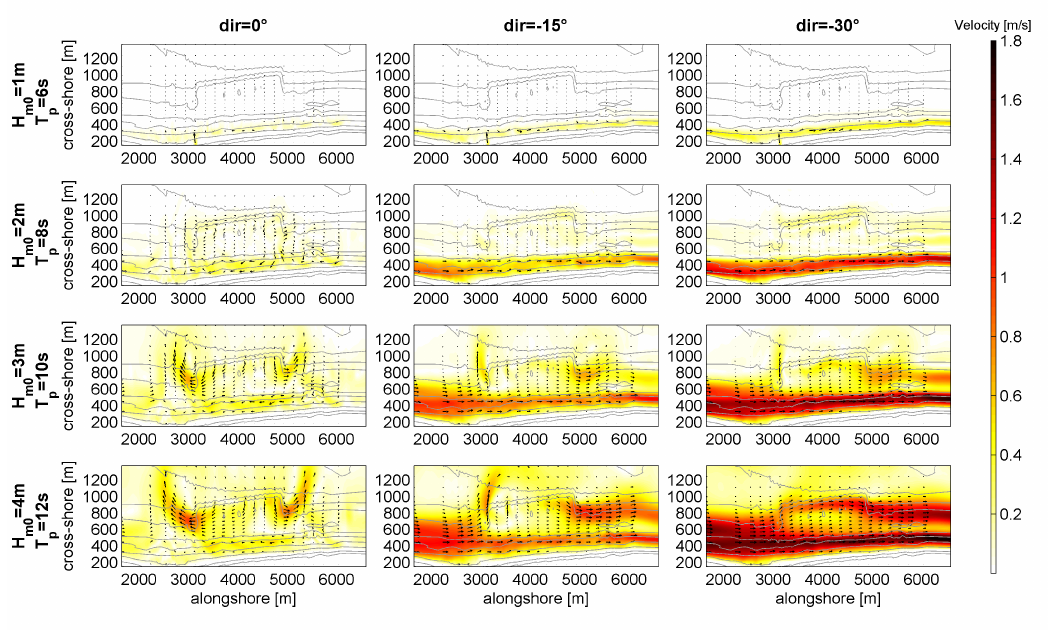
Figure 12. Modelled impact of Ter Heijde’97 shoreface nourishment on the flow patterns depending on the offshore wave height and direction for the first survey moment after construction (T1; January